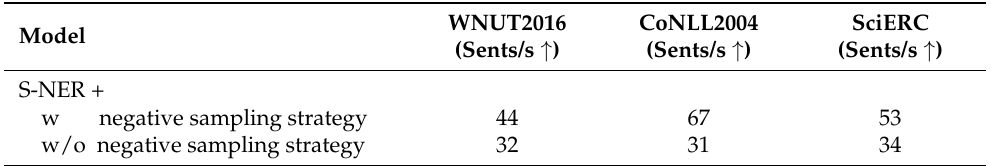
Table 5. Comparisons of model training speed when using and not using the negative sampling strategy. ↑ denotes the larger the value, the faster the speed.